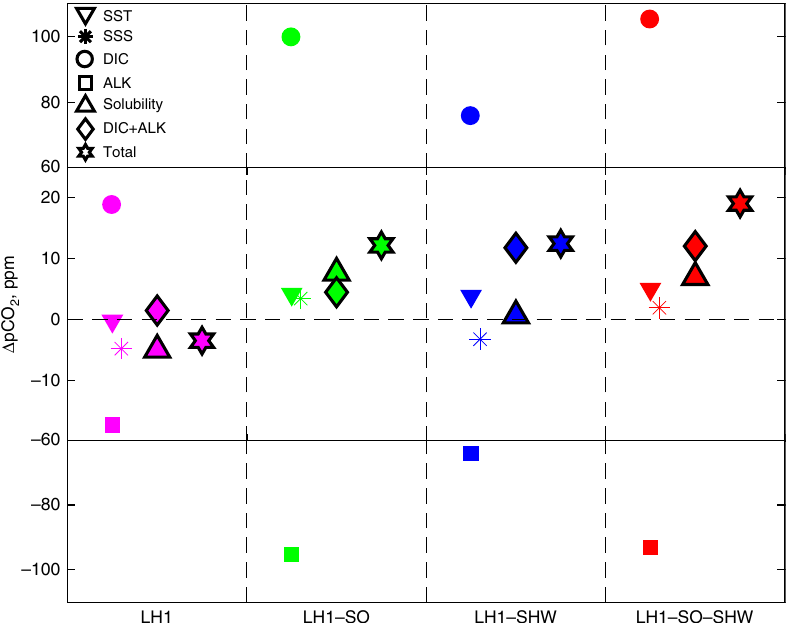
Fig. 5 Attribution of p CO 2 changes. Deconvolution of Δ p CO 2 into (from left to right in each column) its SST (downward-pointing triangles), SSS (six- pointed asterisks), DIC (circles) and ALK (squares); solubility (SST + SSS, upward-pointing triangles) and combined DIC and ALK components (diamonds Methods); and total p CO 2 change (six-pointed stars), for all transient experiments (LH1: weak AABW, magenta; LH1 – SO: strong AABW through buoyancy forcing, green; LH1 – SHW: strong AABW through SH westerlies, blue; and LH1 – SO – SHW strong AABW through buoyancy forcing and wind,